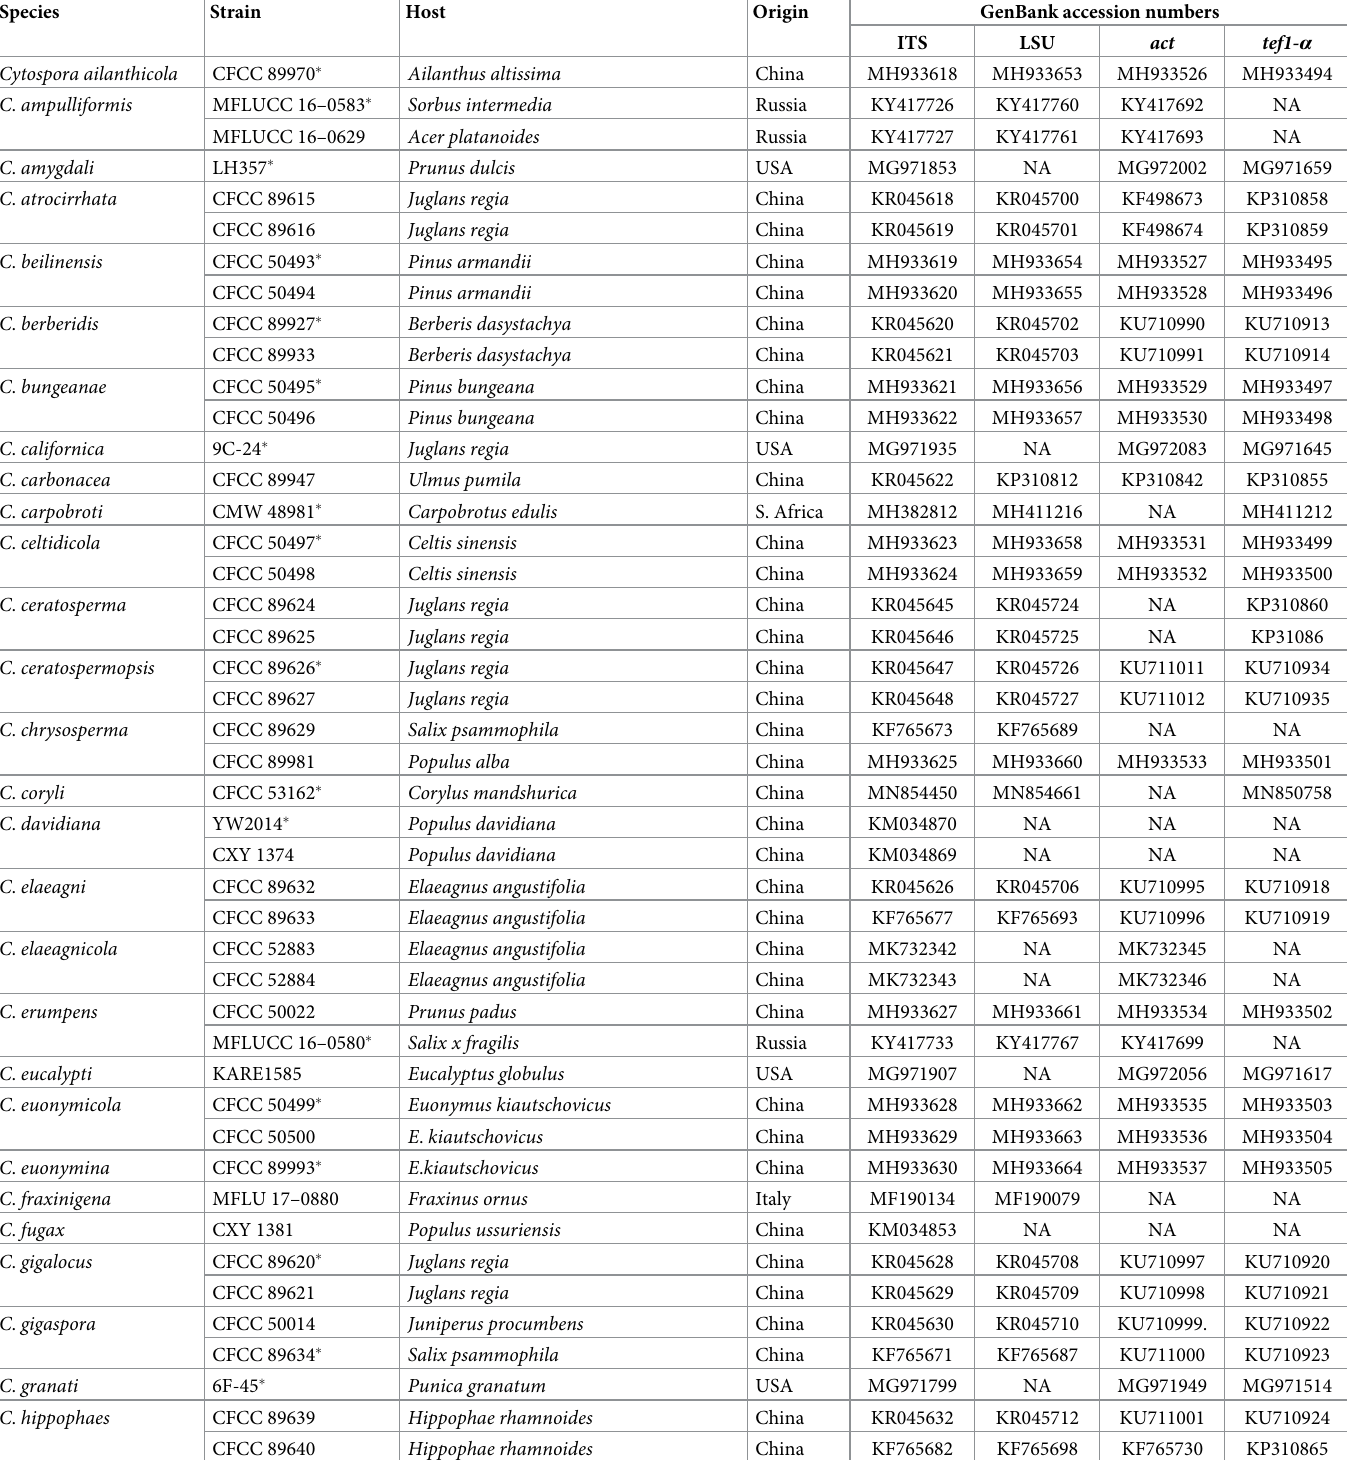
Table 1. Strains used in the phylogenetic analysis with their culture accession and GenBank numbers. Strains from this study are in bold and ex-types are marked with � . NA: not available.